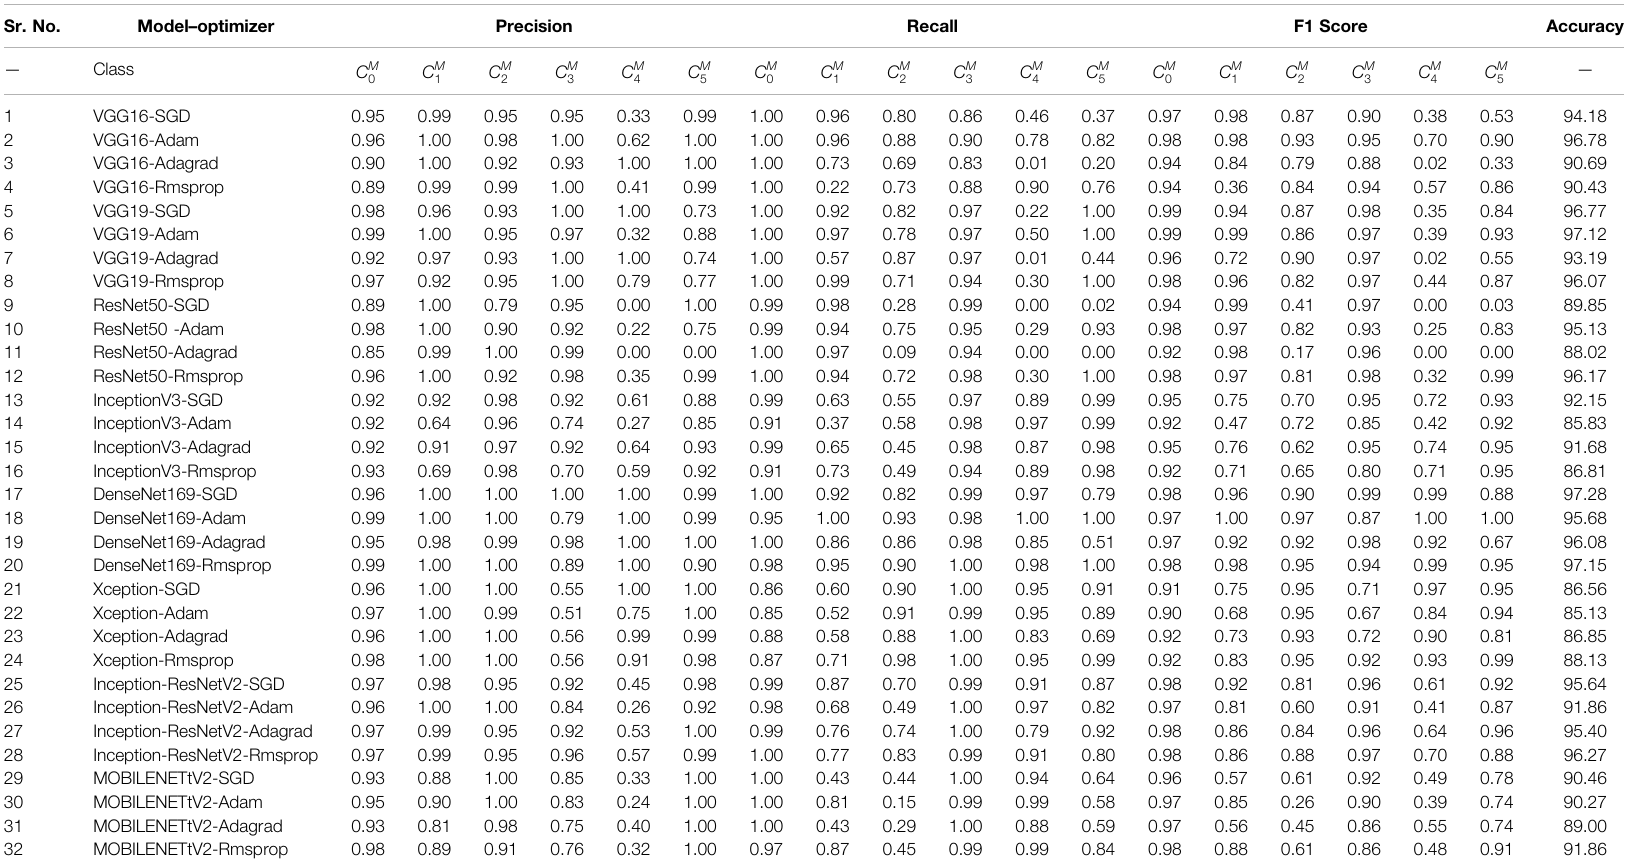
TABLE 9 | | Performance evaluation based on precision, recall, and F1 scores for multi-class classi fi cation [Accuracy (%)]. Sr.